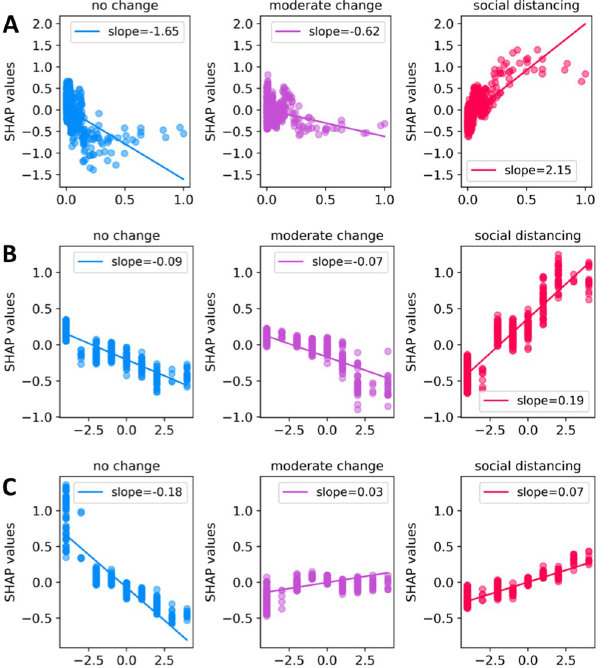
Fig 4. SHAP value plot for the three most important features: A) disease score , B) perceived susceptibility , C) perceived severity